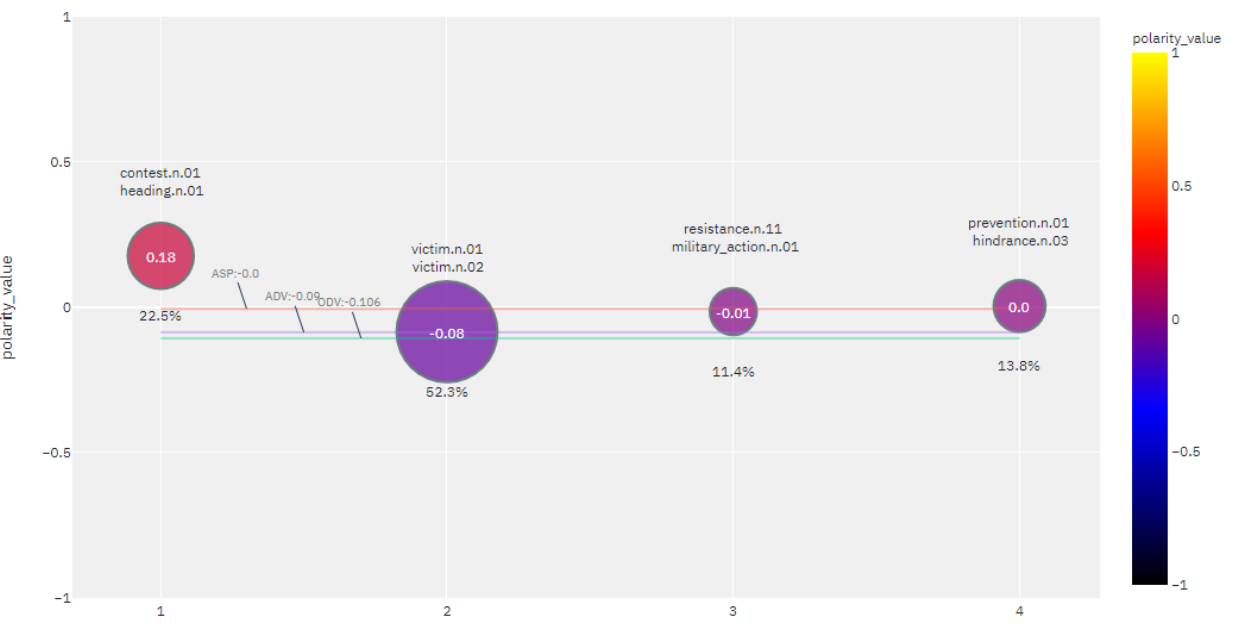
Figure 5. Sentiment potential ( SP ) of lexeme fight-n calculated with SenticNet 6 polarity-value; propagated on pruned graph clusters of 15 best ranked collocates in the first degree and 15 collocates in the second degree within europarl_plenary corpus.